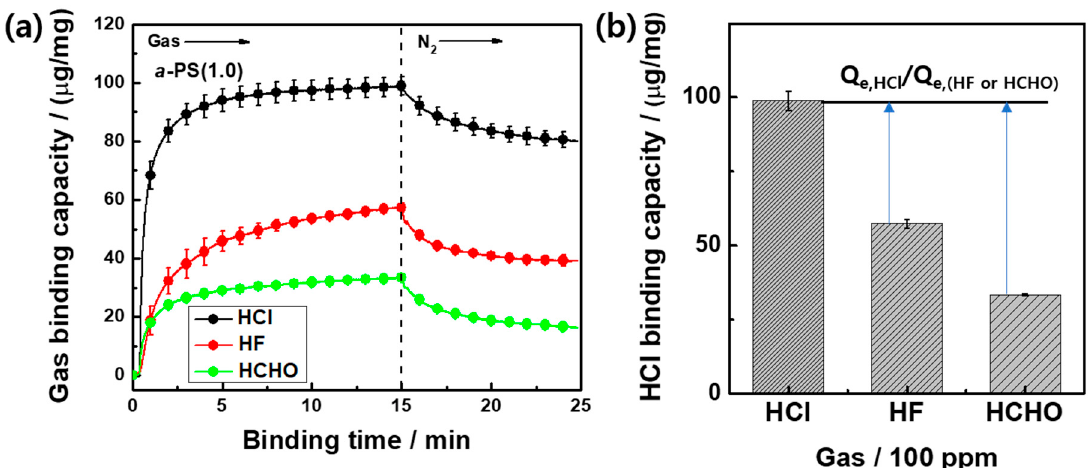
Figure 4. ( a ) The gas binding capacity of the a -PS(1.0) sensor as a function of binding time under the flow of three different gases (HCL, HF, and HCHO) at 100 ppm for a 25 min adsorption/desorption process and ( b ) the selectivity coefficient ( k *) (Q e,HCl /Q e,(HF or HCHO) of HCl with respect to other gases.